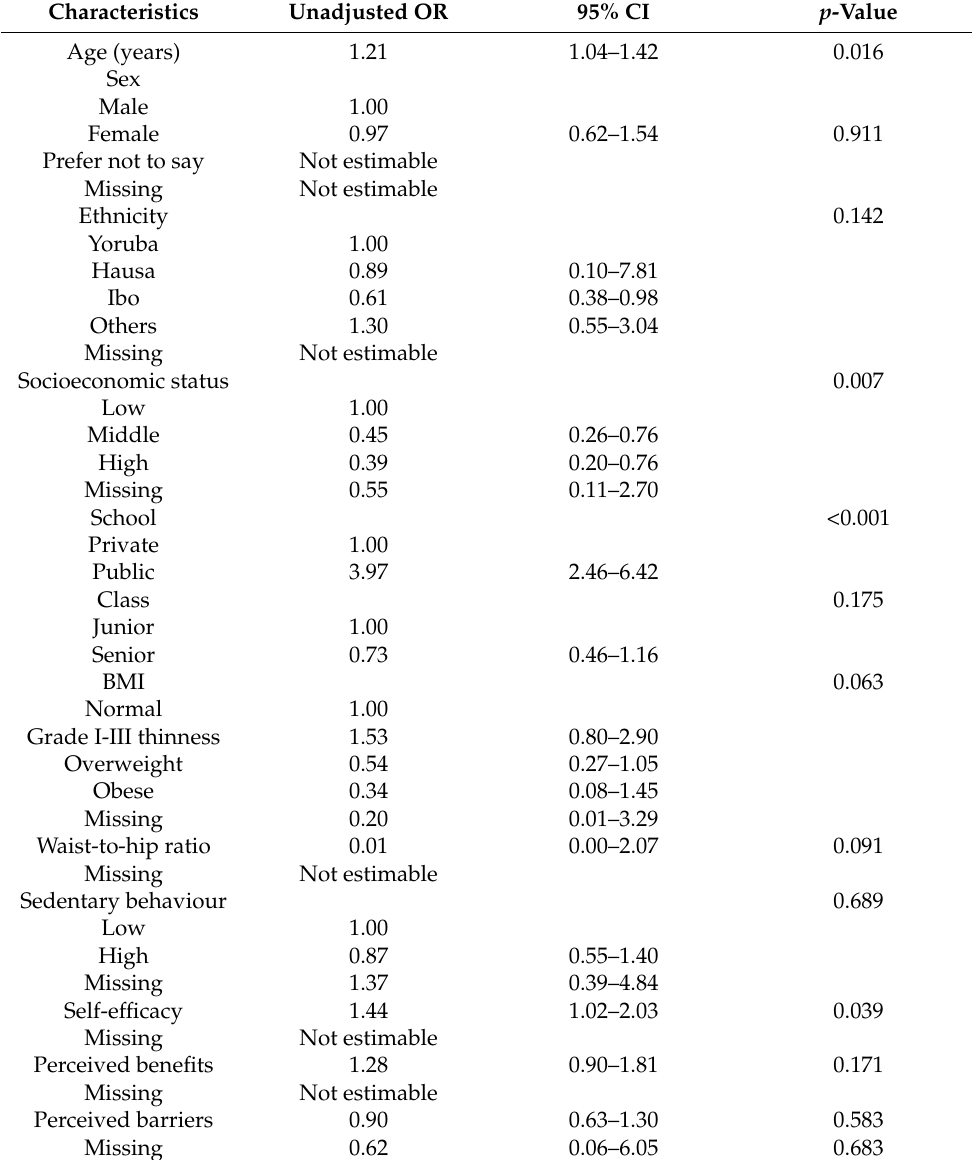
Table 2. Unadjusted association between meeting the recommended MVPA level and predictors. Characteristics